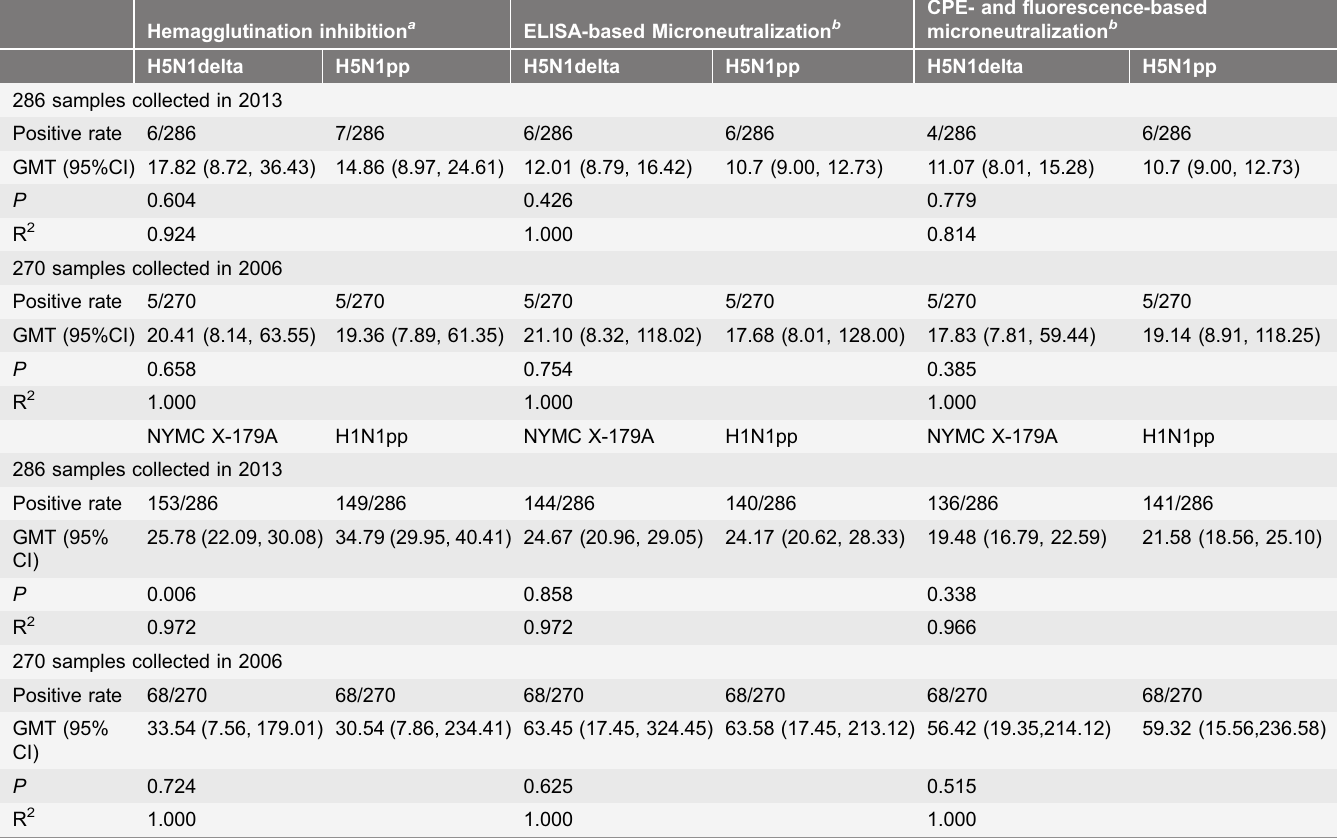
Table 2. Comparative analysis of the viruses and pp in influenza virus-specific nAb detection using population-based sera. Hemagglutination inhibition a ELISA-based Microneutralization